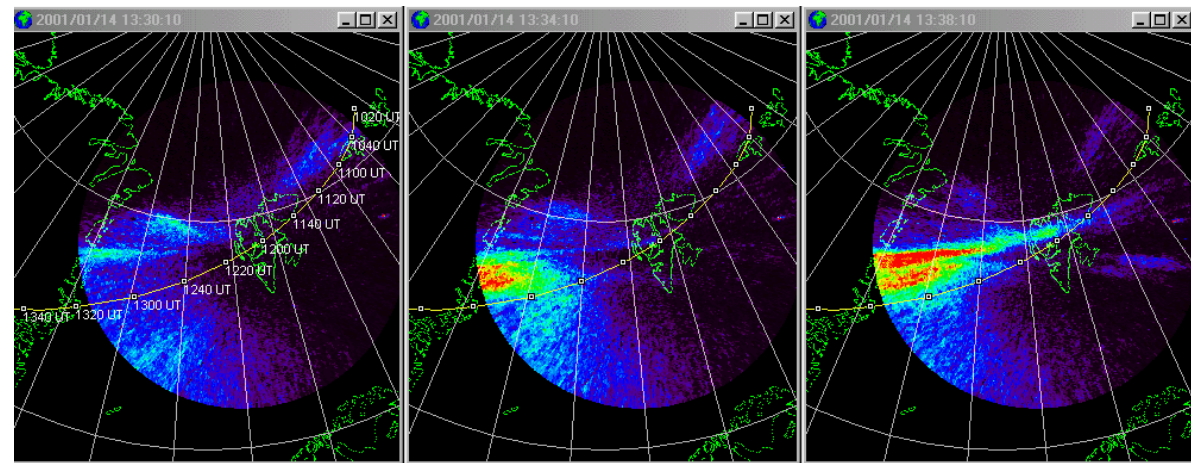
Fig. 12. Three selected all-sky camera images in 630.0nm emissions from the Norwegian camera at NAL. The relevant portion of the projected Cluster orbit is indicated in the images (see time marks in the first